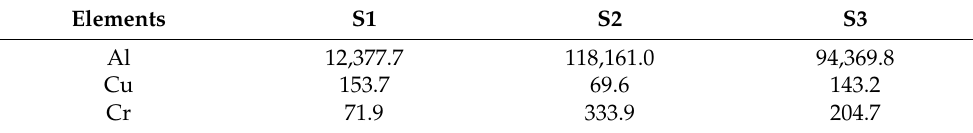
Table 6. Concentration of toxic constituents (Cr, Cu, and Al) obtained from AAS in